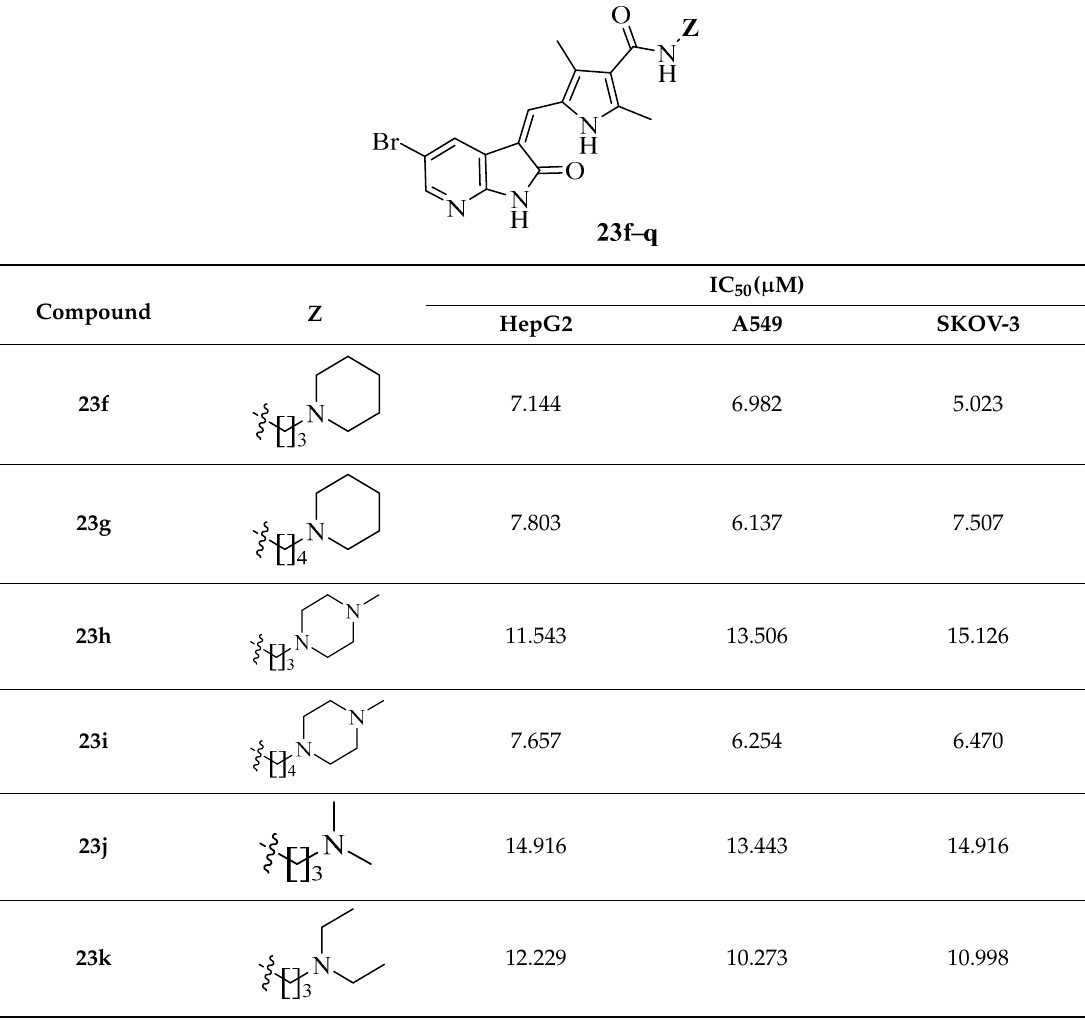
Table 2. In vitro activity of target compounds 23f – q against three cell lines.